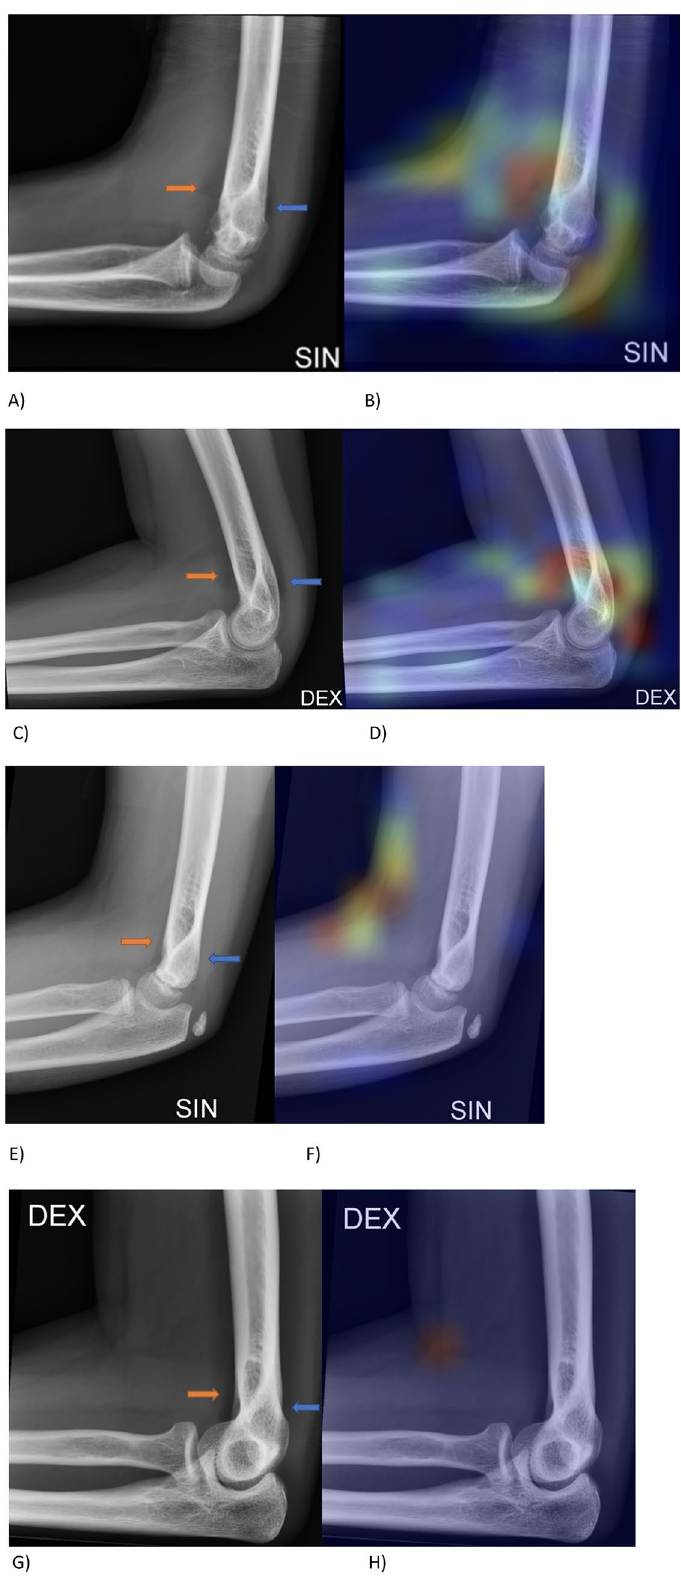
Figure 8. Pediatric (Male, 10y) and adult (Female, 19y) patient with joint effusion ( A , C ) seen anteriorly (orange arrow) and posteriorly (blue arrow) but without visible fracture. Heat map highlights joint effusion ( B , D ). Pediatric (Female, 8y) and adult (Female, 36y) patient with no joint effusion ( E , G ) anteriorly (orange arrow) or posteriorly (blue arrow) and without visible fracture. Heat map does not highlight normal joint effusion ( F , H